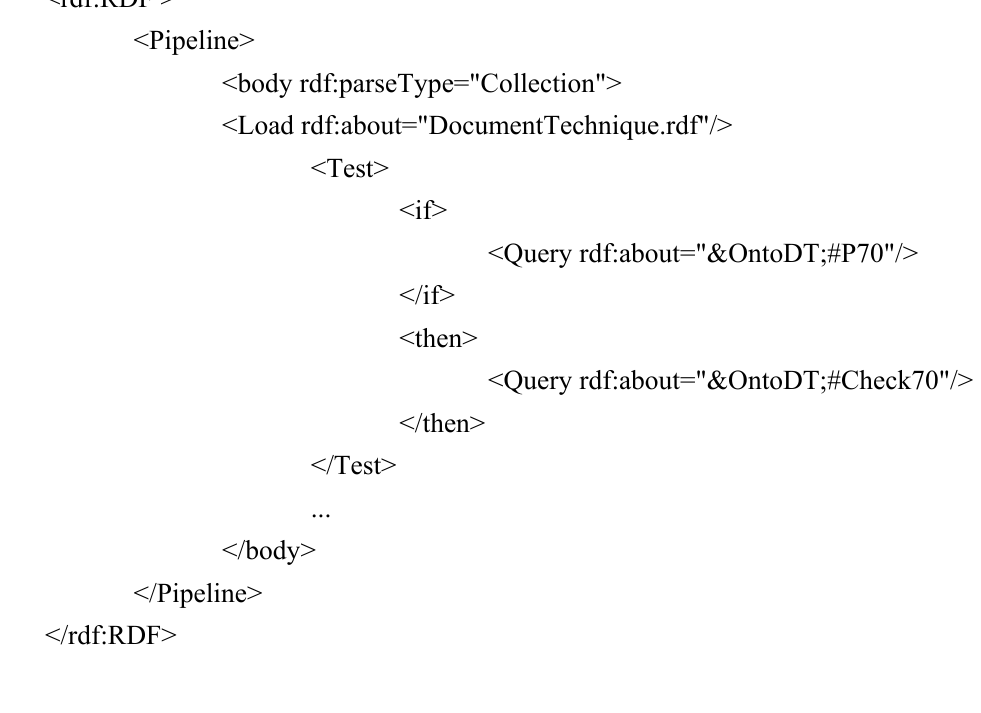
Figure 11. A SPARQL query template for identifying conditional